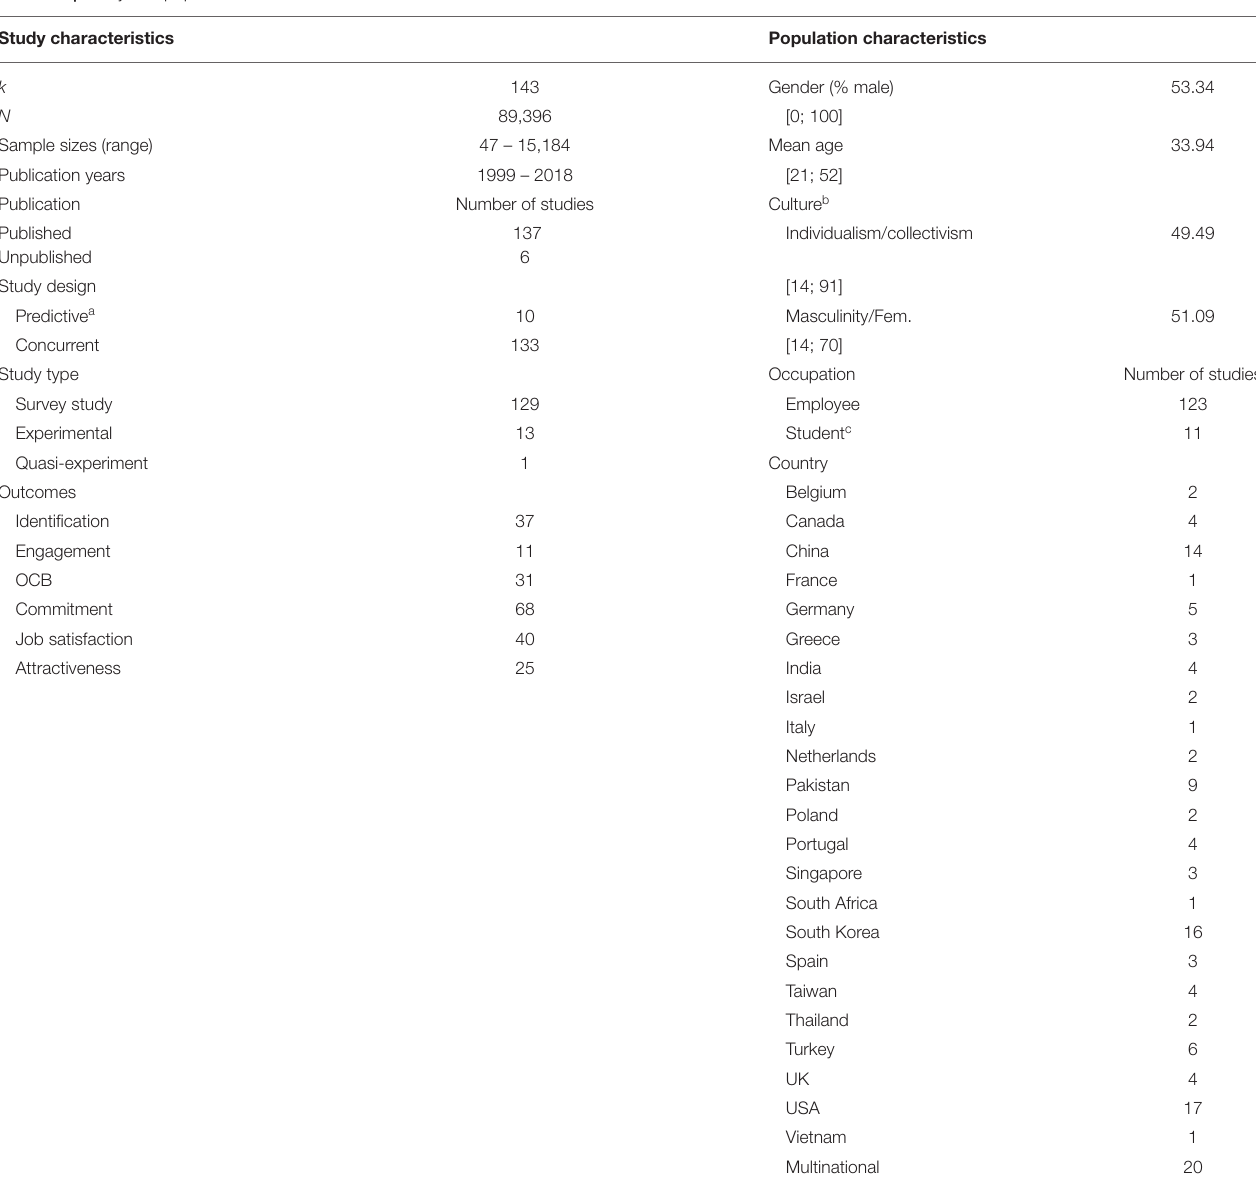
TABLE 1 | Study and population